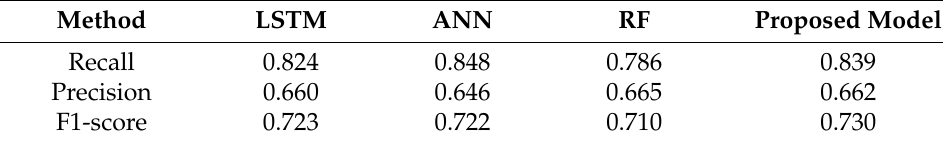
Table 6. Total average performances of the compared